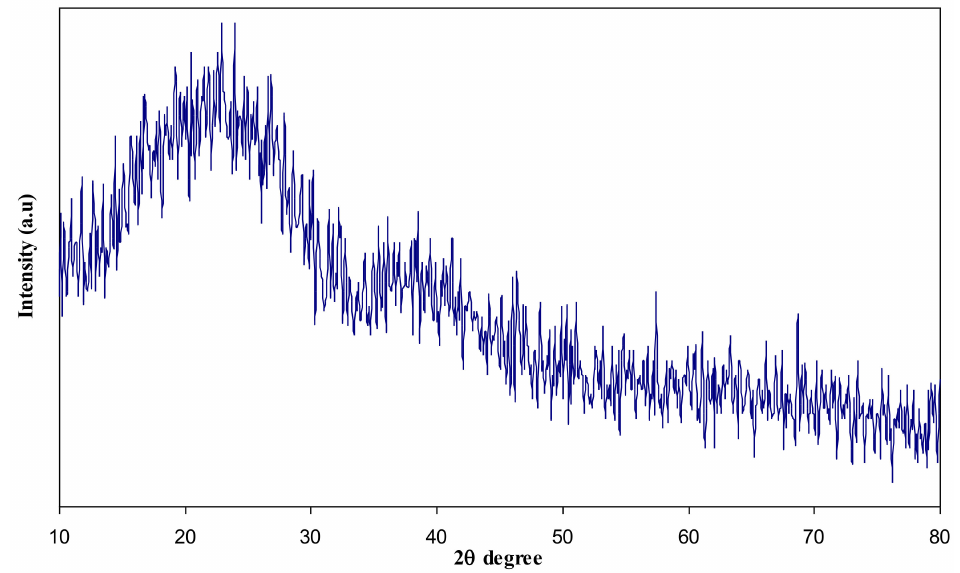
Figure 3. XRD pattern of CS:AgNt solid electrolyte